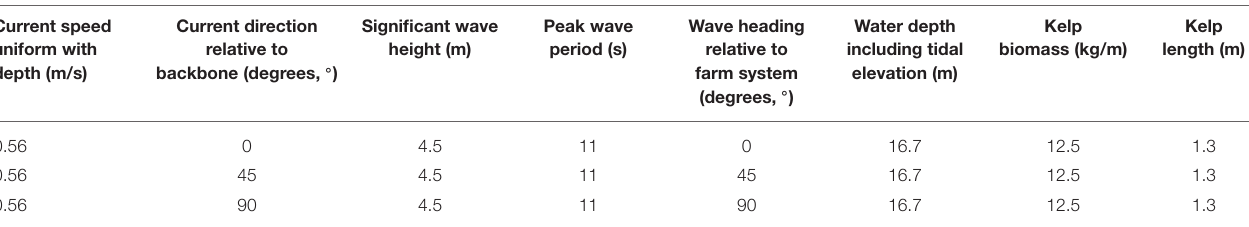
TABLE 1 | Environmental input parameters for extreme storm loading on the farm system.